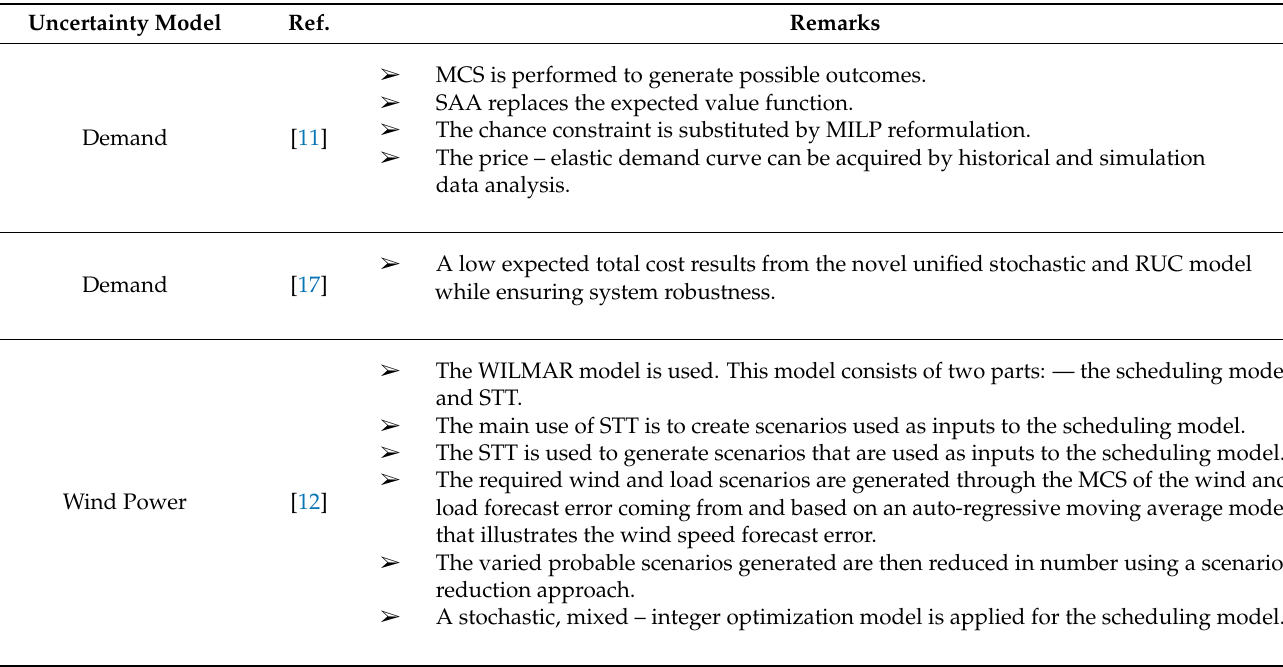
Table 7. Studies that Use Stochastic